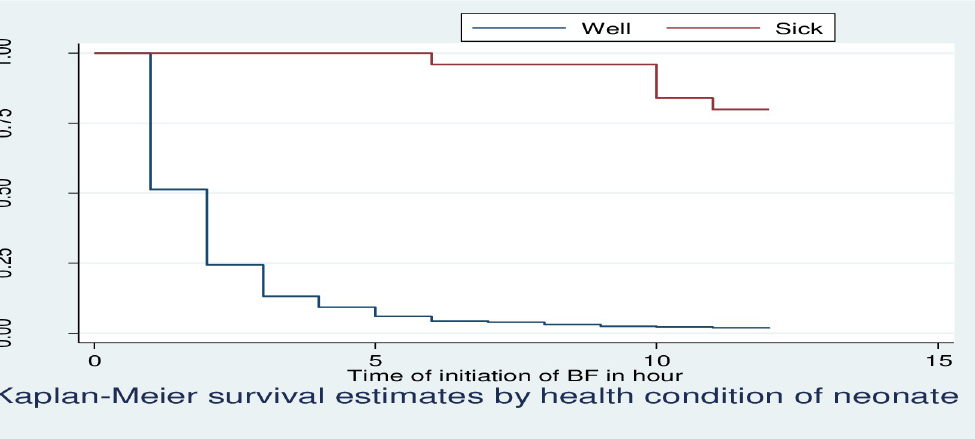
Fig 6. KM survival estimates by health condition of the neonate among postnatal mothers within 12 hours of giving birth in Debre Markos Comprehensive Specialized Hospital, East Gojjam Zone, North West, Ethiopia, 2020.